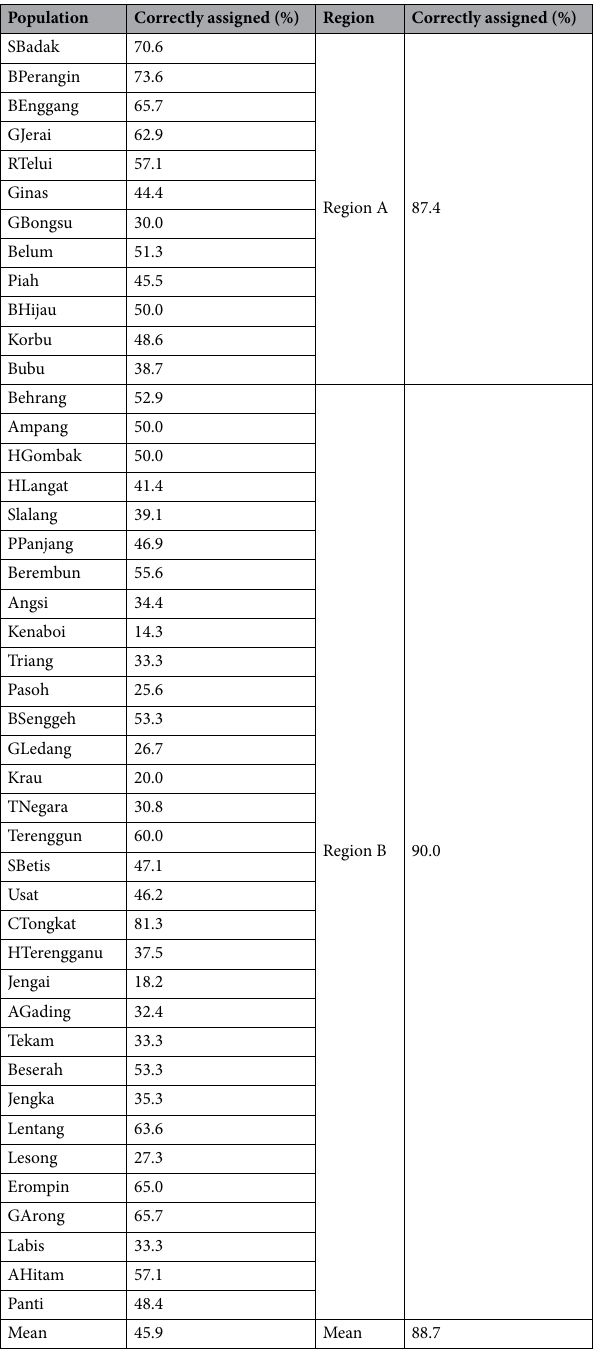
Table 2. Self-assignment test outcomes for Shorea leprosula individuals at the population and regional levels.